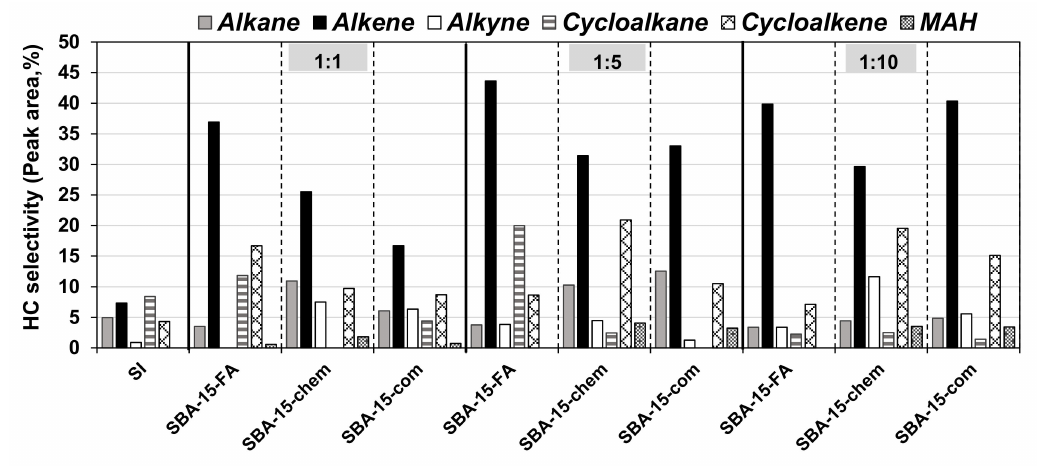
Figure 11. Hydrocarbon distribution of thermal and catalytic pyrolysis of the SI residues using SBA-15